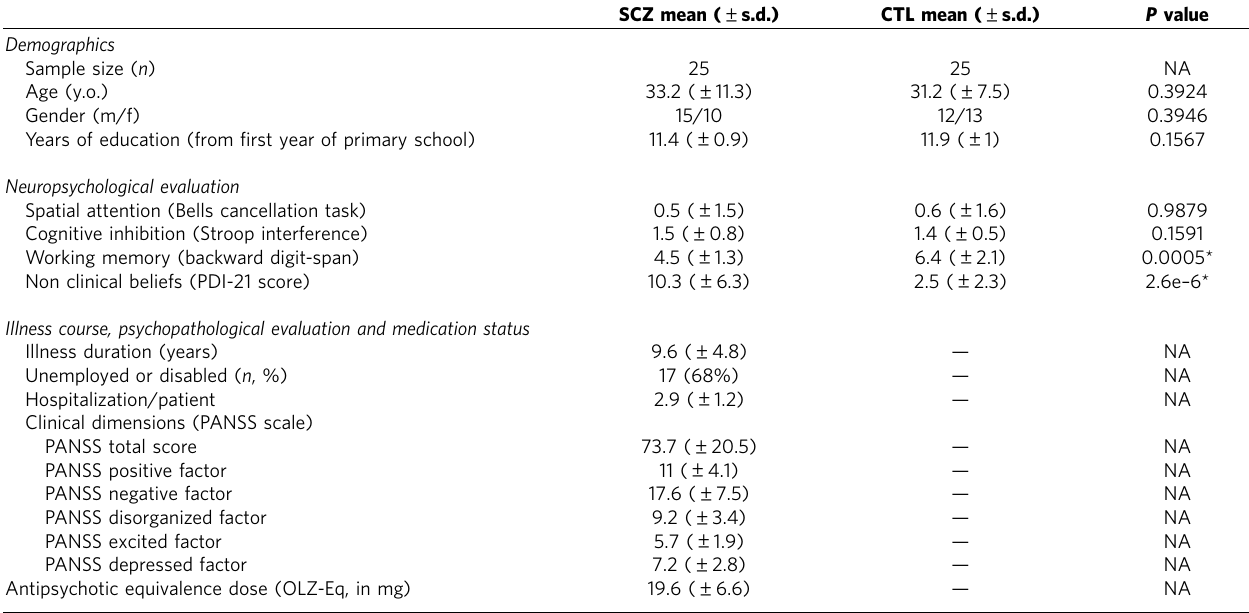
Table 1 | Characteristics of the recruited